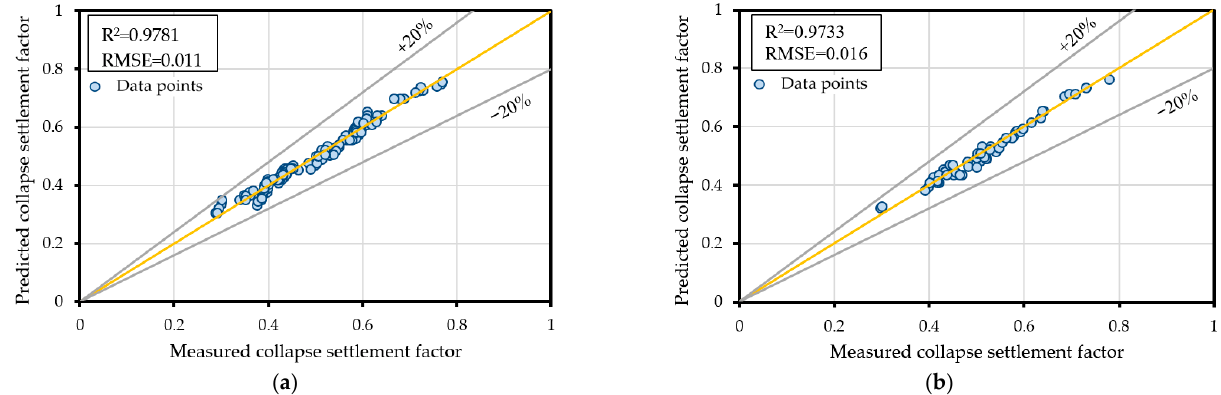
Figure 10. Comparing the results of the predicted and measured coefficient of stress release based on the tangent hyperbolic function. ( a ) Training data, ( b ) Testing data.